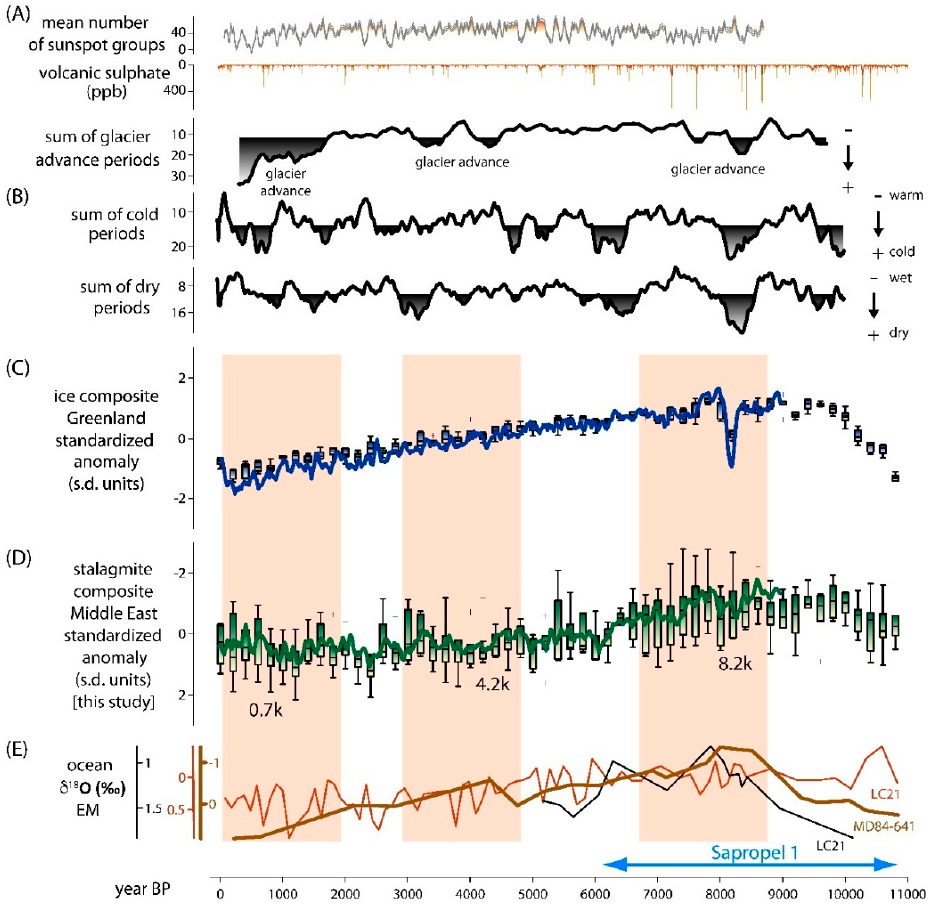
Figure 6. Holocene overview of the δ 18 Occ of ME speleothem records in comparison with additional terrestrial and marine palaeo-archives. ( A ) Reconstructed sunspot number along with its 68% confidence interval [152] and volcanic aerosol based on empirical orthogonal function analysis performed in ice cores from Greenland [139,171]. ( B ) Sum of ice glacier advances, cold and dry periods [32]. ( C ) Composite δ 18 O data from Greenland ice-cores [172]. ( D ) Composite of the SISAL δ 18 Occ from ME and Eastern Europe speleothems reviewed in this study. The composites in ( C , D ) are shown as normalized anomalies (standard units) with a box width: 200-year intervals; central mark: median; edges of the box: 25th & 75th percentiles; whiskers: extreme values (~99% of data); plusses: outliers (~1% of data); boxes connected with a 3-point running average of 25-year bin means. ( E ) Eastern Mediterranean planktonic δ 18 O profiles of site LC21 [64,109] (light brown line: Globigerinoides ruber , black line: Neogloboquadrina pachyderma ) and site MD84-641 [140] covering the Holocene. The shaded areas highlight important early, middle and late Holocene climate events discussed in the text (8.2, 4.2 and 0.7 ka, respectively).